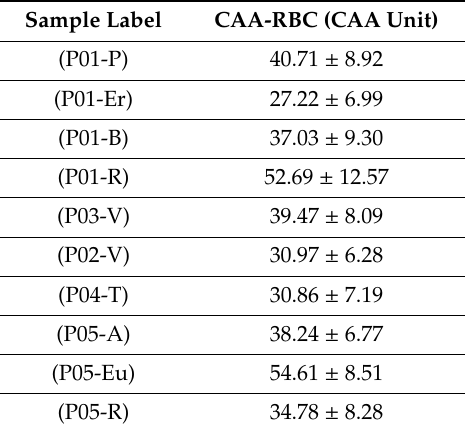
Table 3. Cellular antioxidant activity in red blood cells (CAA-RBC) results of ethanol bee pollen extracts. CAA unit data were derived from five distinct healthy volunteers’ blood samples and expressed as mean ± standard deviation (SD).